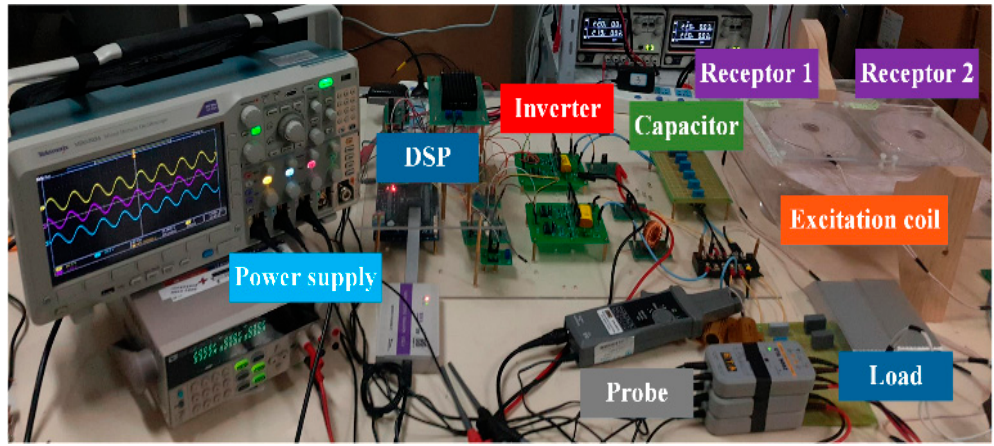
Figure 11. Experimental prototype.